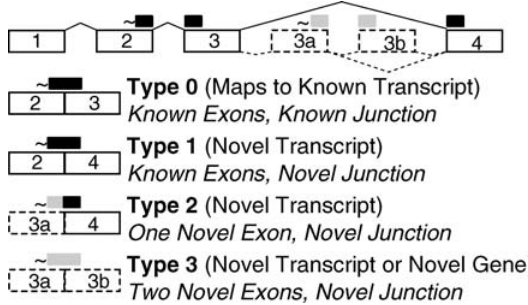
Figure 1. Tags That Span a Splice Junction May Reveal Novel Genes or Novel Transcripts This schematic demonstrates four known exons (1, 2, 3, and 4, boxes in solid lines). The 3 9 -most NlaIII enzyme restriction site (represented as ; ) lies near the 3 9 edge of exon 2 and a known predicted SAGE tag (long black bar) spans exons 2 and 3 (Type 0 tag). Predicted exons (boxes in dashed line) 3a and 3b are examples of exons predicted by SAGE2Splice. Three other types of tags (Types 1 to 3) have been defined as potential candidates in SAGE2Splice predictions. Tag portions arising from known exons (short black bar), whereas tag portions arising from novel exons (short gray bar). Solid lines connecting exons indicate known combina- tions, whereas dashed lines indicate unknown combinations. DOI: 10.1371/journal.pcbi.0020034.g001